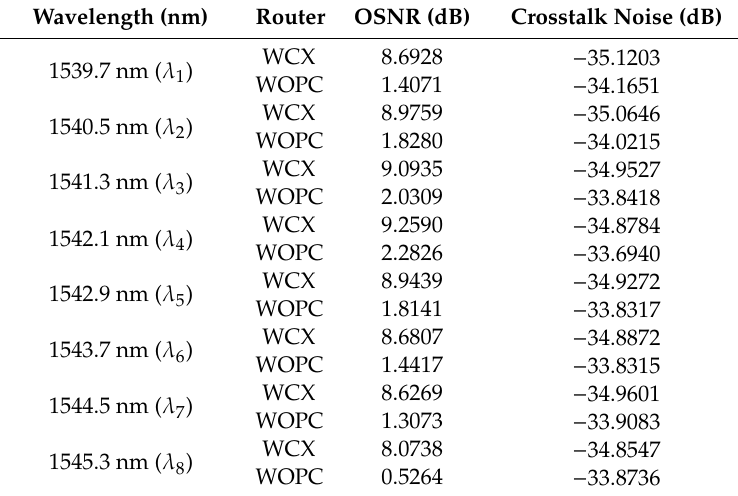
Table 4. OSNR and crosstalk noise for each of the panel in Figure